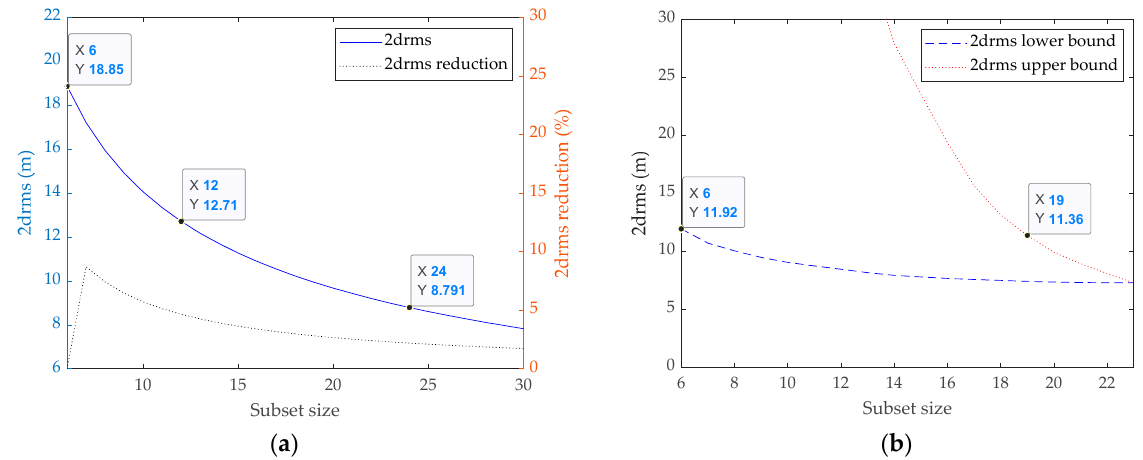
Figure 1. ( a ) Minimal 2drms value and 2drms reduction to the former for each size subset in the ideal scene; ( b ) Accuracy variation range for each size subset in the practical